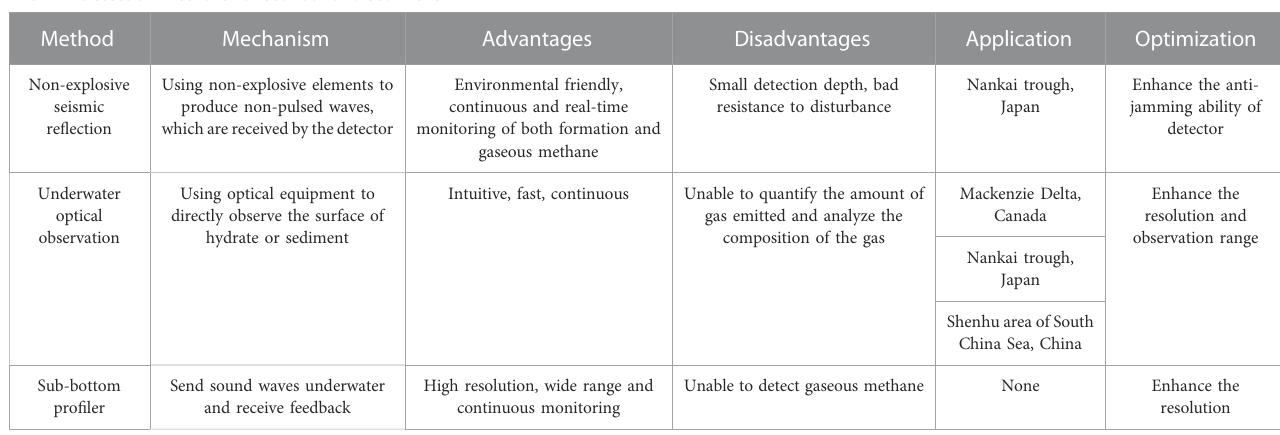
TABLE 2 Detection methods for sea fl oor and